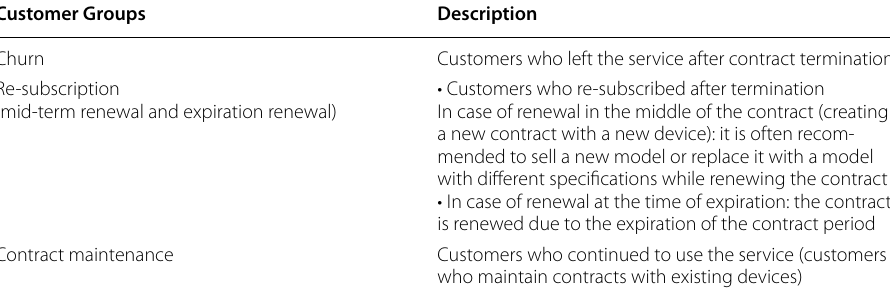
Table 1 customer groups classified by contract type and contract